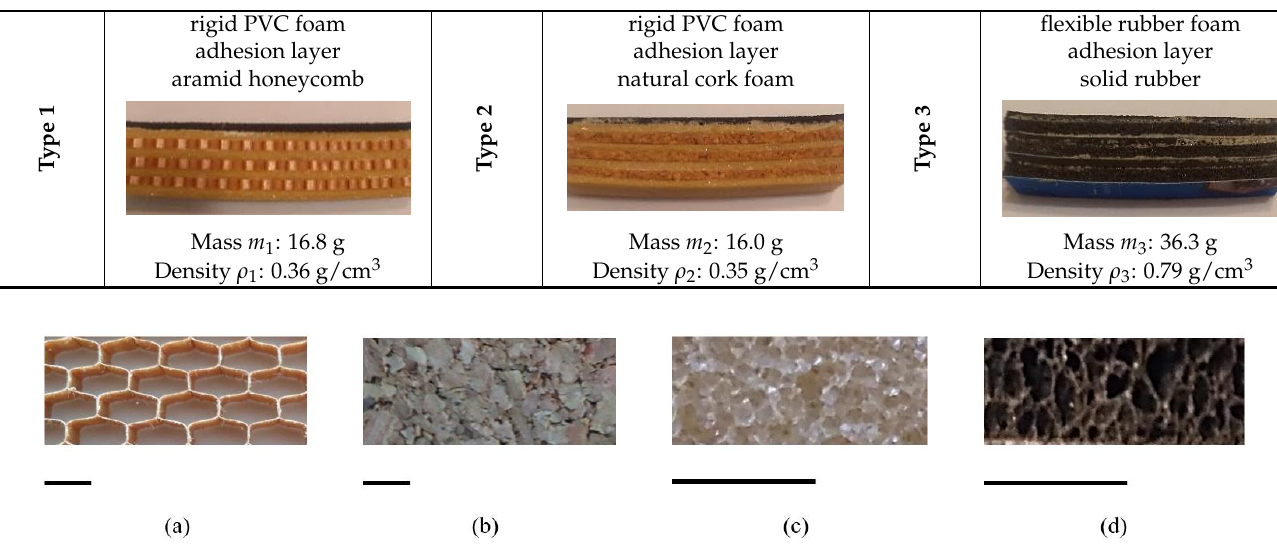
Figure 4. Aramid over-expanded cell honeycomb ( a ), natural cork ( b ), polyvinyl chloride (PVC) foam ( c ), synthetic rubber foam ( d ), line below corresponds to 5 mm.